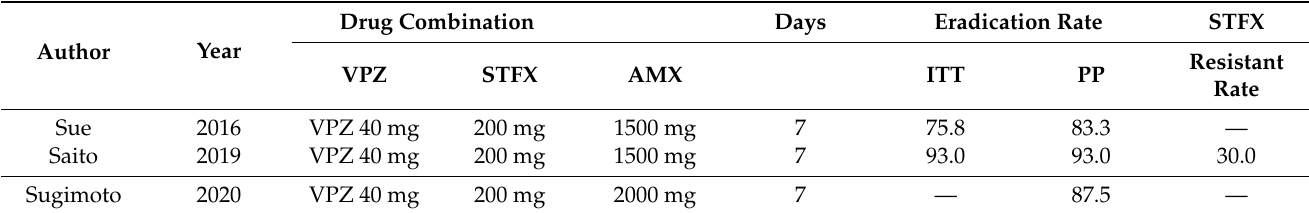
Table 2. Efficacy of vonoprazan (VPZ)–sitafloxacin (STFX)–amoxicillin (AMX). Figure 2. Eradication rates of 7 days regimen with PPI (proton pump inhibitor) or vonoprazan. (VPZ)–sitafloxacin (STFX)– amoxicillin (AMX). RPZ: rabeprazole; EPZ: esomeprazole.